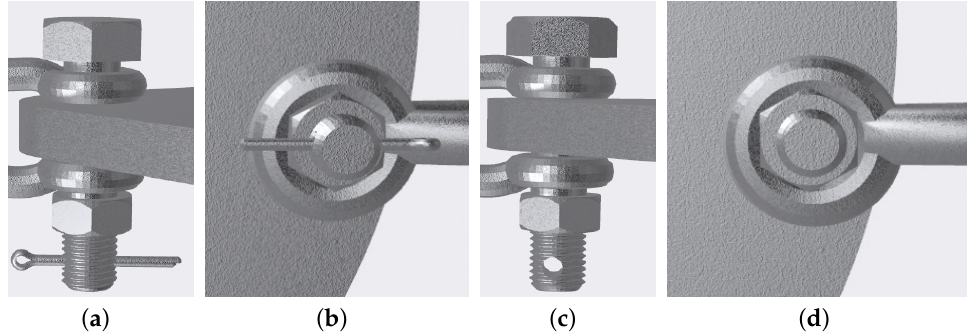
Figure 2. 3D display of the bolt. Position relationship between the pin and the bolt from the ( a ) front view and ( b ) from the bottom view. Bolt component without the pin ( c ) from the front view and ( d ) from the bottom